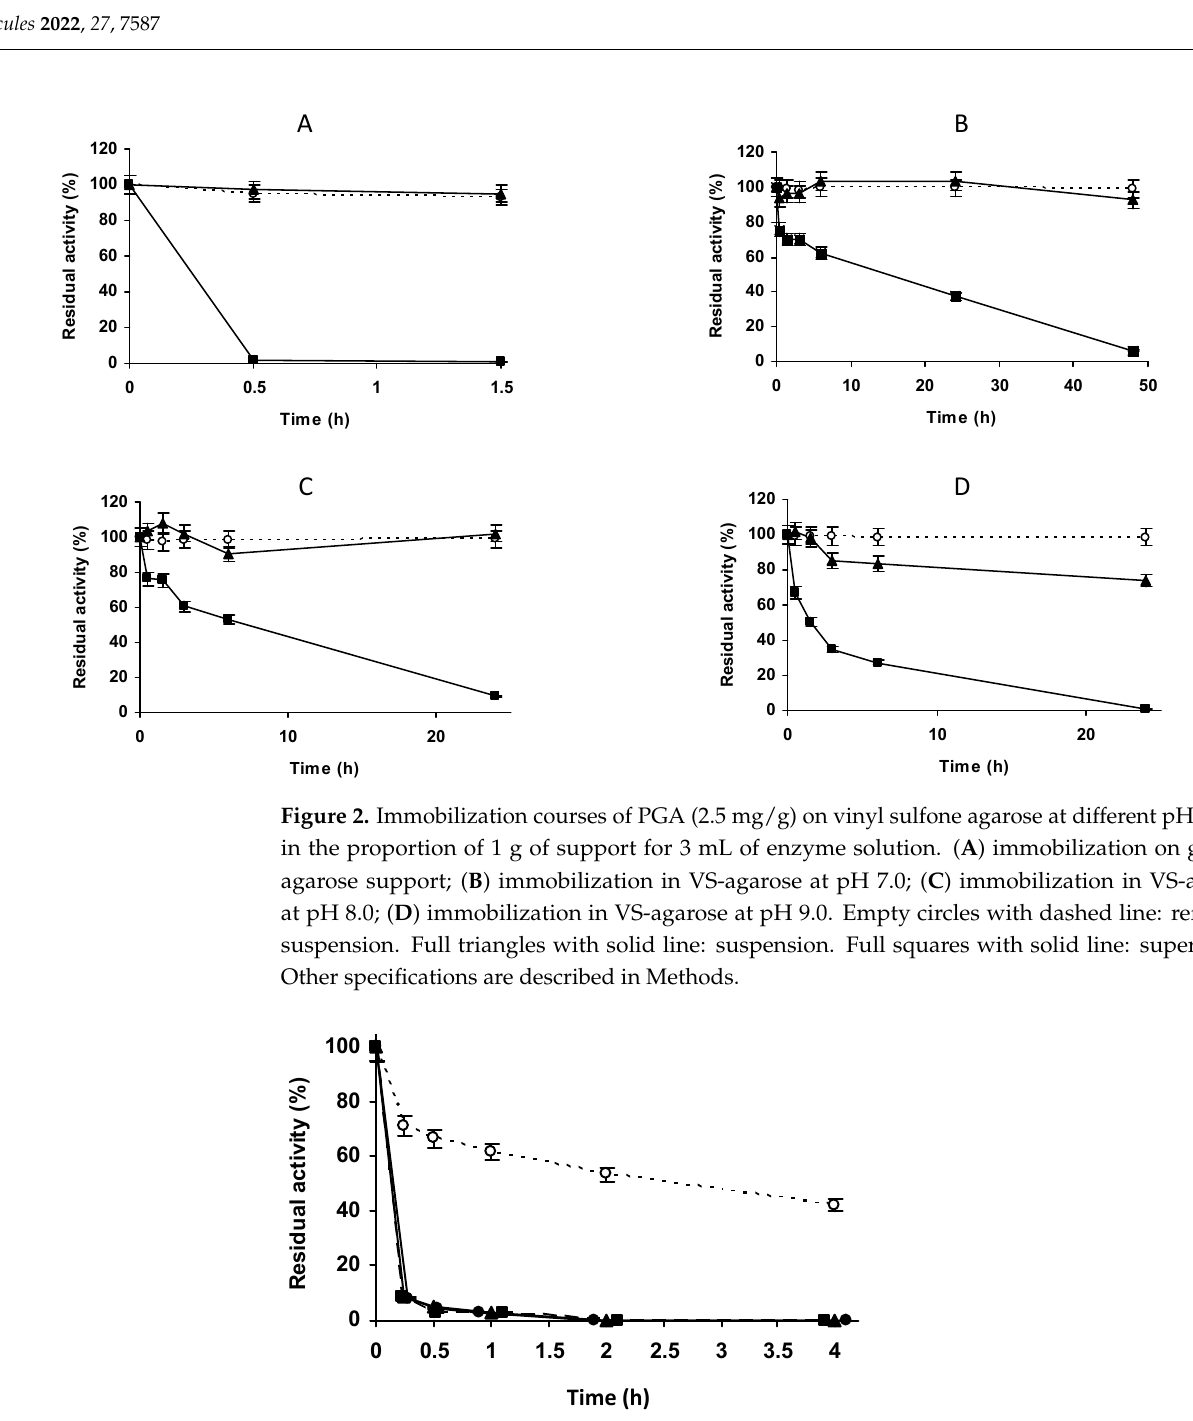
Figure 3. Thermal inactivation courses of PGA immobilized at different pH values. The enzyme was immobilized, in the proportion of 1 g of support to 3 mL of enzyme solution. Incubation was carried out in 50 mM sodium carbonate at pH 9.0 for 3 h and blocked with 2 M glycine at pH 8.0 for 48 h. Empty circles with dashed line: glyoxyl agarose-PGA. Full triangles with solid line: immobilization at pH 7.0. Full squares with solid line: immobilization at pH 8.0. Full circles with solid line: immobilization at pH 9.0. Other specifications are described in the Methods.